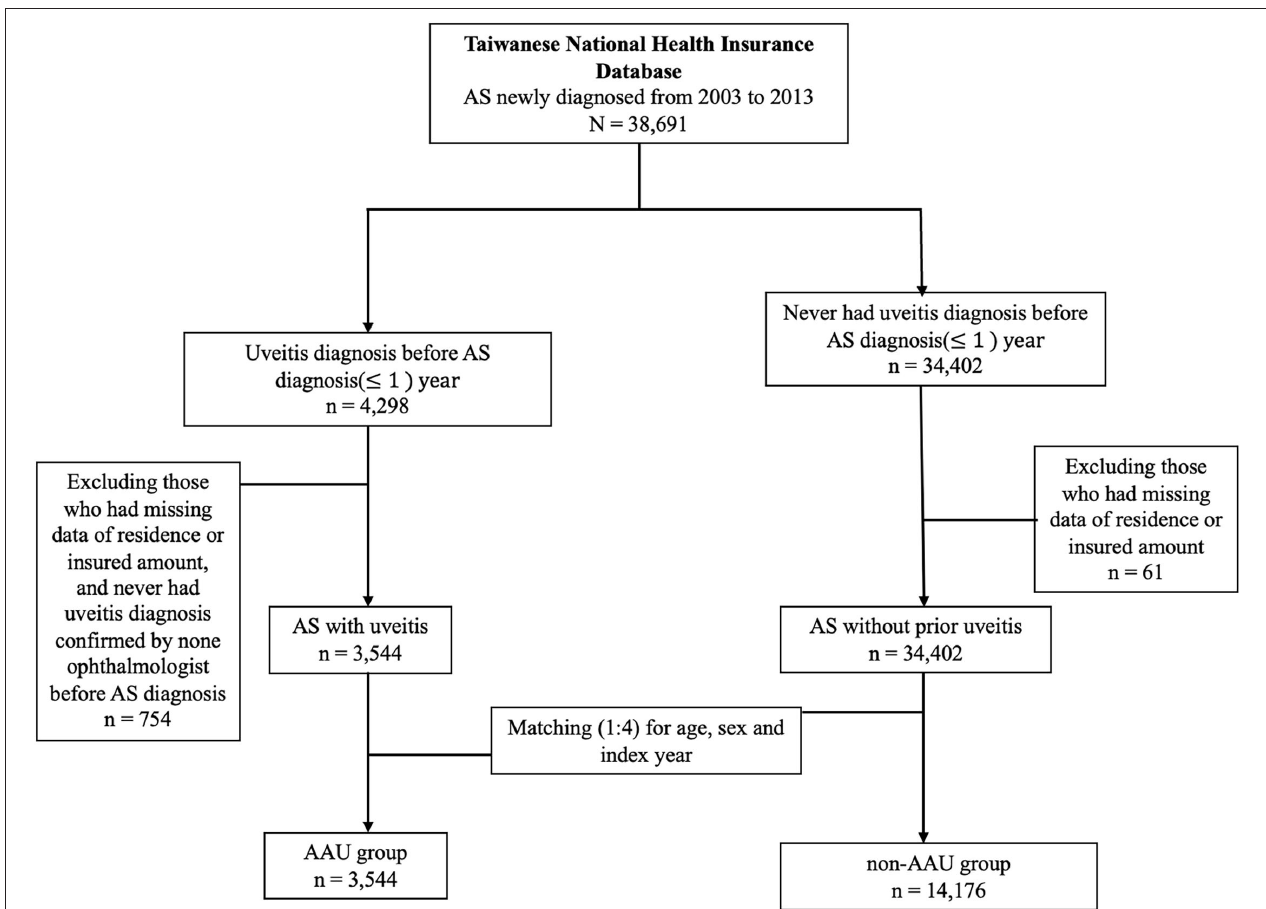
FIGURE 1 | Flow chart of inclusion